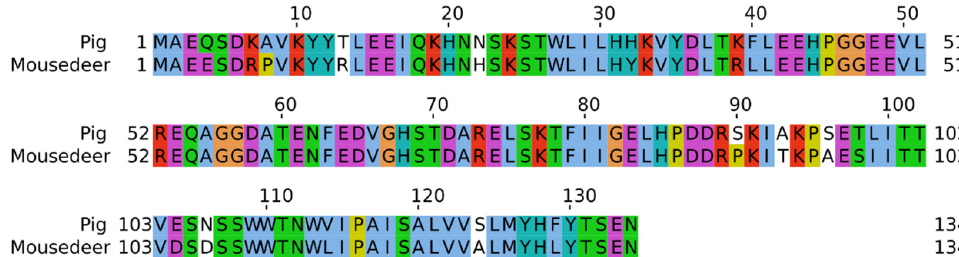
Figure 4. The comparison of deduced amino acid sequence of CYB5 between mouse deer and pig. The homologous sequences between mouser deer and pig are highlighted.